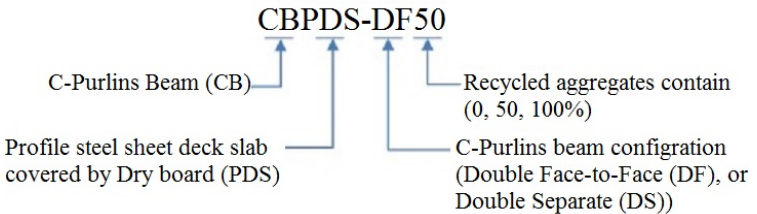
Figure 1. Nomenclature of specimen.